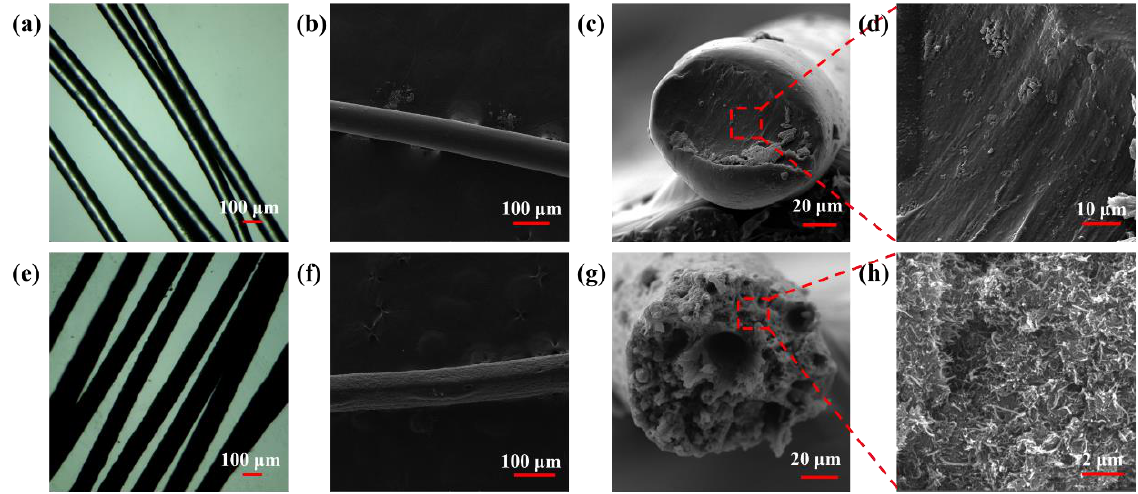
Figure 2. Micrograph ( a ) and SEM images ( b – d ) of pure PVA fibers; micrograph ( e ) and SEM images of ( f – h ) uMWCNT-Fs.